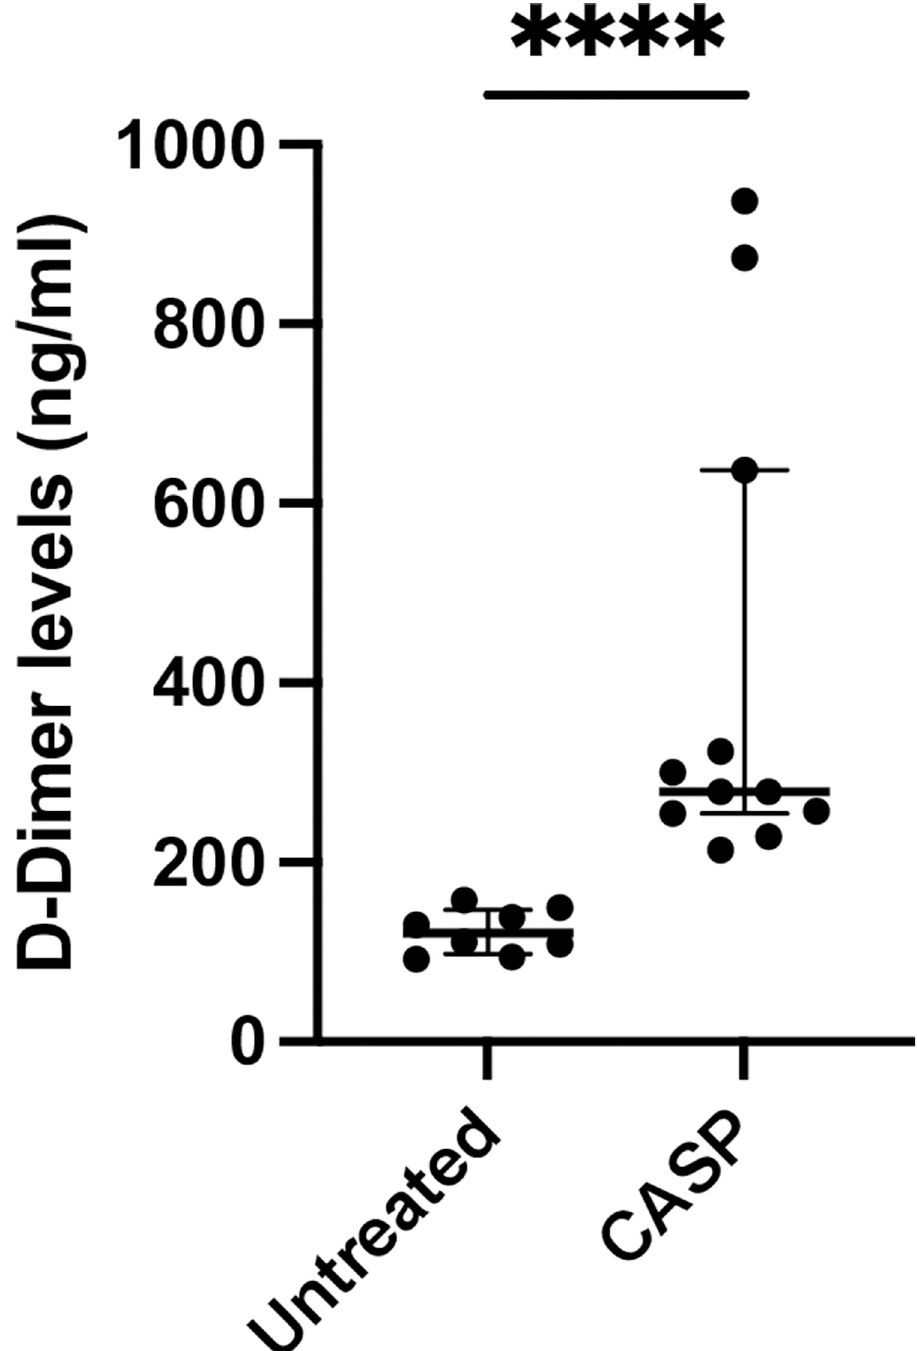
Fig 4. D-dimer levels in the blood of untreated or CASP-operated C57Bl/6 mice. Statistical results of D-dimer levels 20 h after CASP surgery (CASP, black column) or untreated (white column) 8- to 10-week-old C57Bl/6. Basal blood levels of untreated animals 120.9 (66.2 IQR) ng/ml increased significantly to 278.6 (722.9 IQR) ng/ml in CASP- operated mice (p < 0.0001 ���� ; n = 8 untreated group; n = 11 CASP group); The bold black line depicts the median.